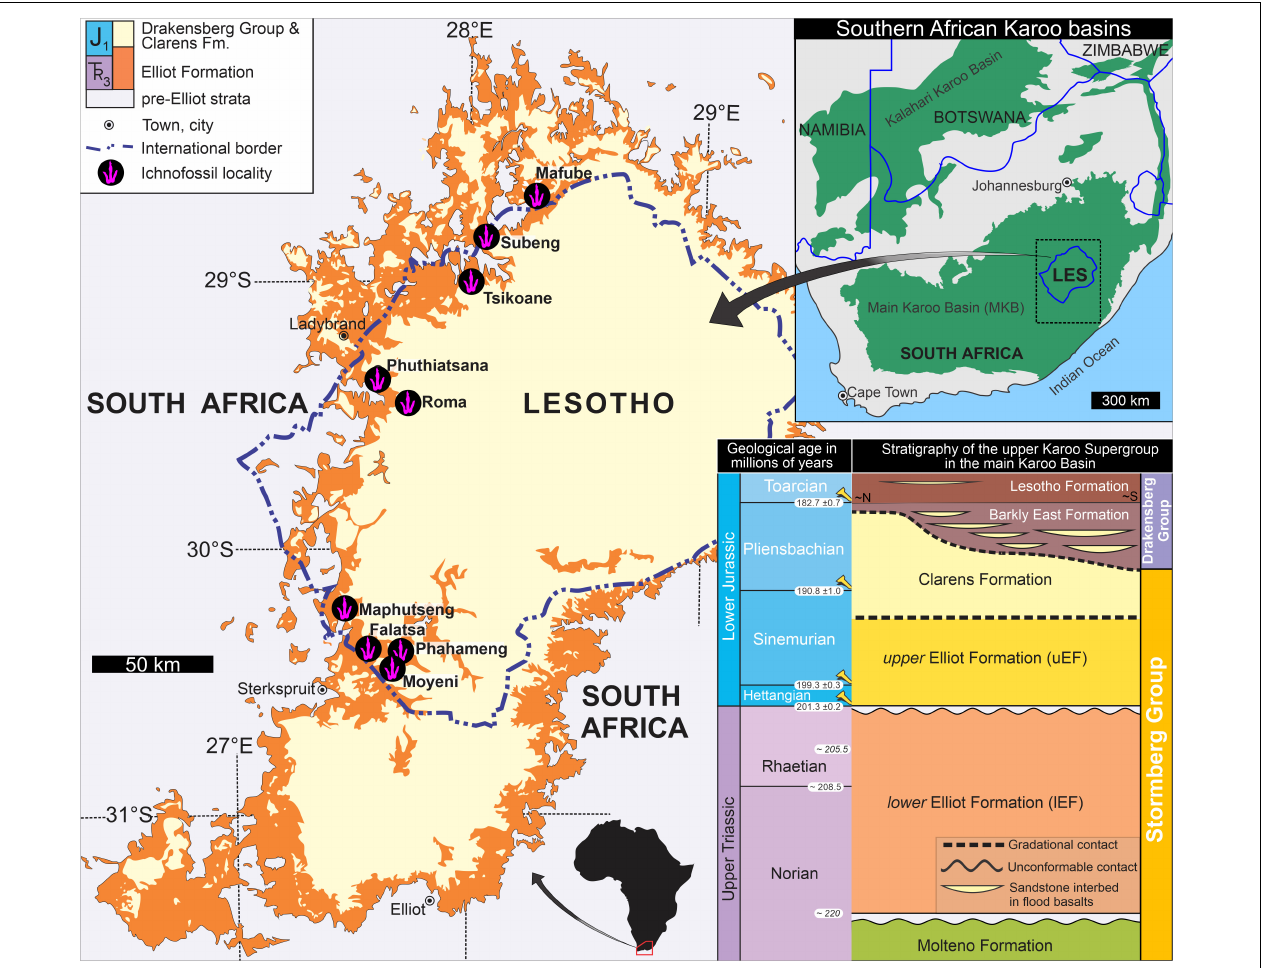
FIGURE 1 | Overview geological map of the upper Stormberg Group showing the geographic distribution of the ichnofossil sites reviewed in this study. Insets on the right are the map of the Karoo basins in southern Africa and the chronostratigraphic table of the Upper Triassic–Lower Jurassic Stormberg Group, upper Karoo Supergroup. Geological time scale is based on the International Chronostratigraphic Chart (v2021) and Cohen et al. (2013). At Moyeni and Roma, multiple tracksites are recorded (see Supplementary Table 1 for GPS co-ordinate